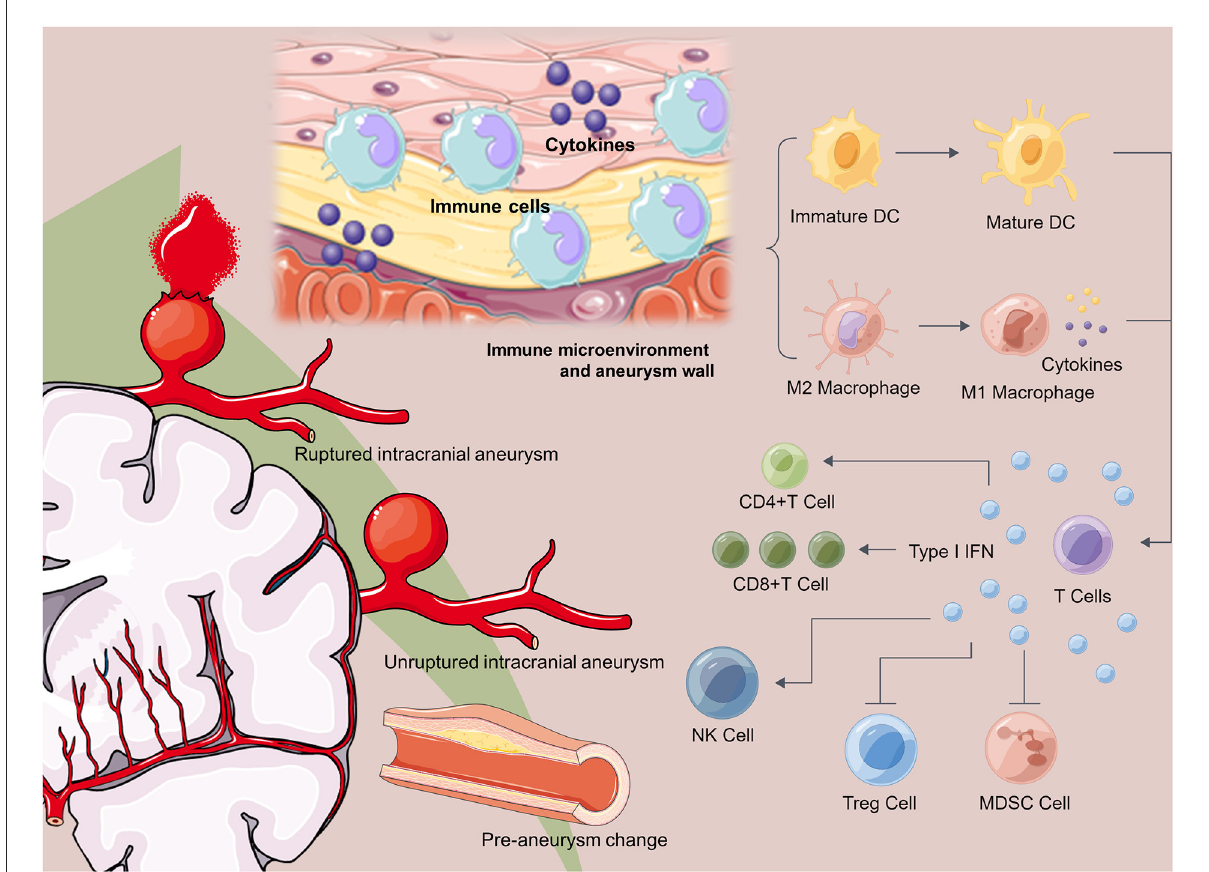
FIGURE1 Immunology and inflammation for intracranial aneurysms. The development of intracranial aneurysm includes three stages: pre-aneurysm stage, unruptured intracranial aneurysm and ruptured intracranial aneurysm. Dysregulation of immune microenvironment and inflammation infiltration are the most important pathological characteristics of aneurysm wall. Immune cells and cytokines participate into the dysregulation of immune microenvironment in aneurysm